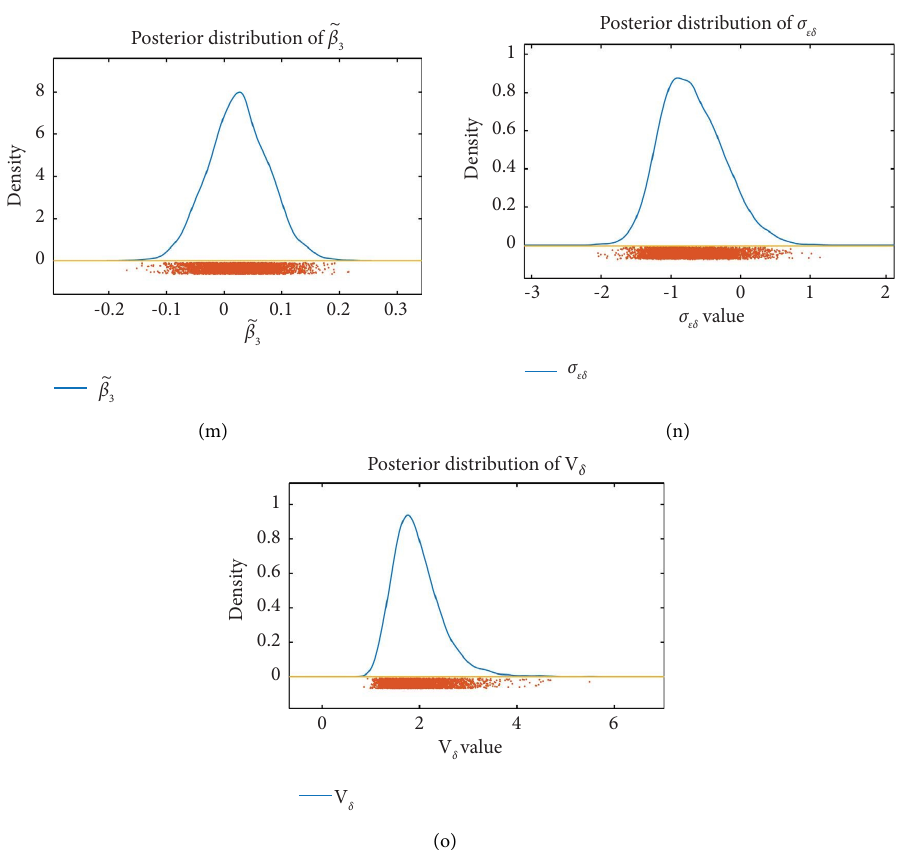
Figure 10: Posterior distributions of parameters. (a) Posterior distribution of ρ . (b) Posterior distribution of c . (c) Posterior distribution of 0 c . (d) Posterior distribution of β . (e) Posterior distribution of β . (f) Posterior distribution of β . (g) Posterior distribution of β . 1 1 2 3 4 (h) Posterior distribution of β . (i) Posterior distribution of β . (j) Posterior distribution of β . (k) Posterior distribution of 􏽥 β . (l) Posterior 5 6 7 1 . (m) Posterior distribution of 􏽥 β . (n) Posterior distribution of σ . (o) Posterior distribution of V . distribution of 􏽥 β εδ δ 2 3 Table 4: Estimation results of the SARBP-EWM model and binary probit model for weekday and weekend. Explanatory